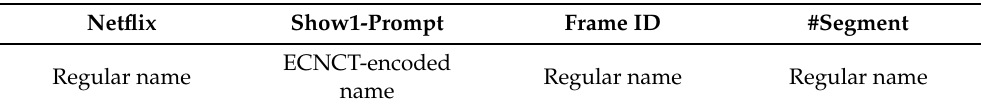
Table 2. An example of an ECNCT